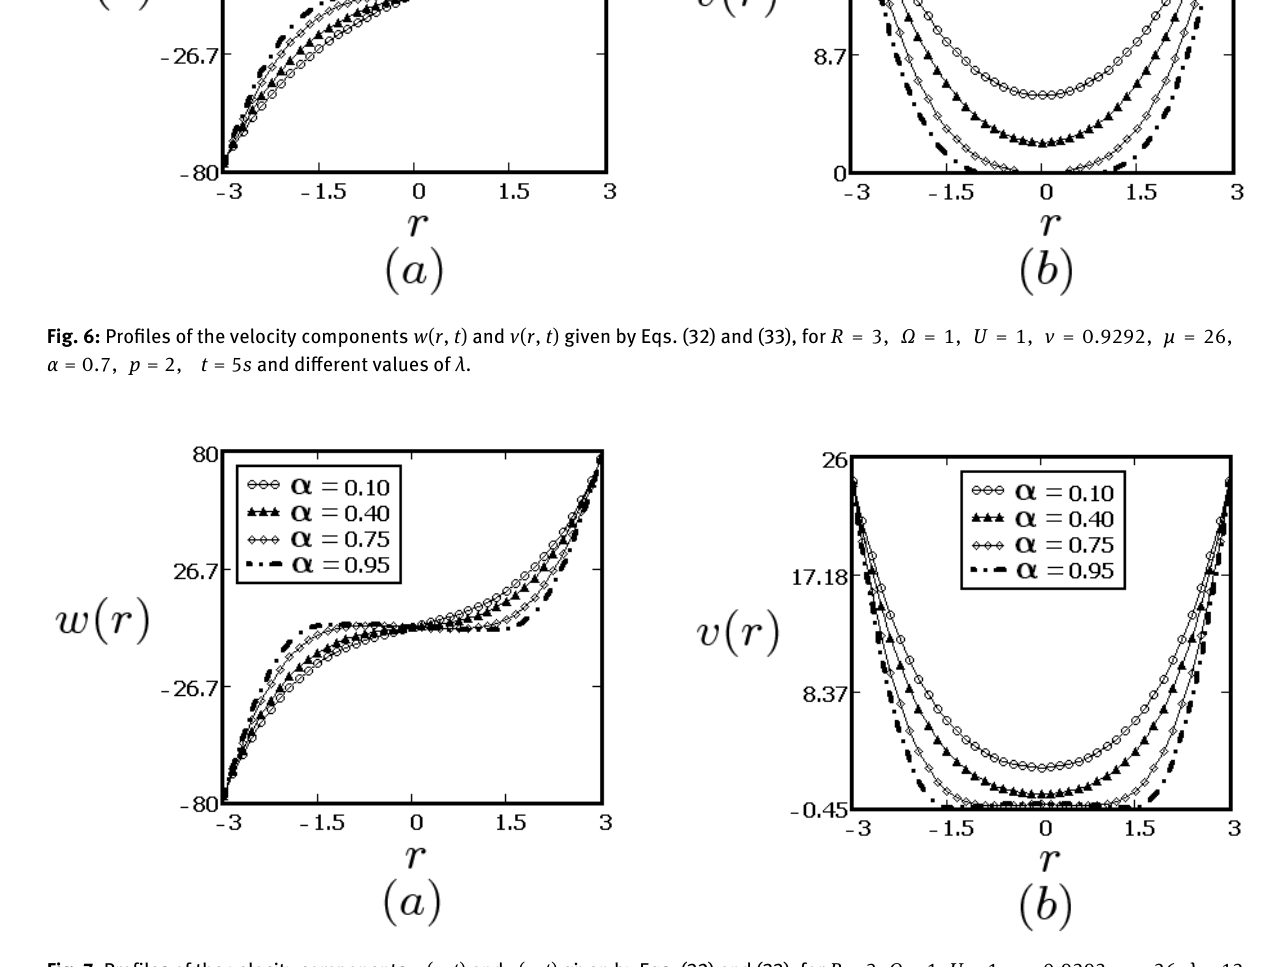
Fig. 7: Profiles of the velocity components w ( r , t ) and v ( r , t ) given by Eqs. (32) and (33), for R = 3, Ω = 1, U = 1, ν = 0.9292, µ = 26, λ = 12, p = 2, t = 5 s and different values of α